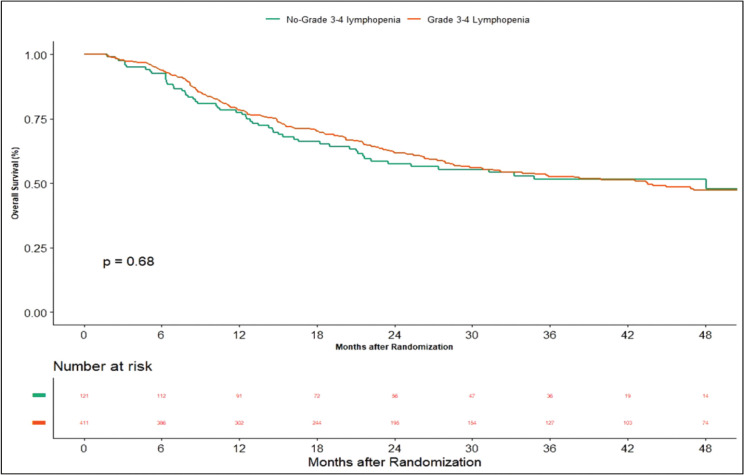
Kaplan–Meier curve showing overall survival in grade 3–4 and non-grade 3–4 lymphopenia.